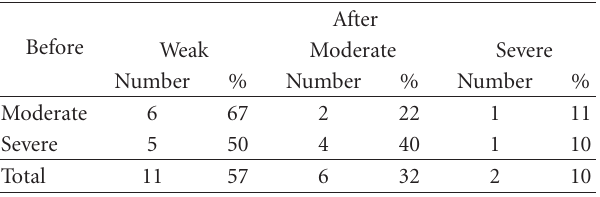
Table 3: Grade of pruritus before and after